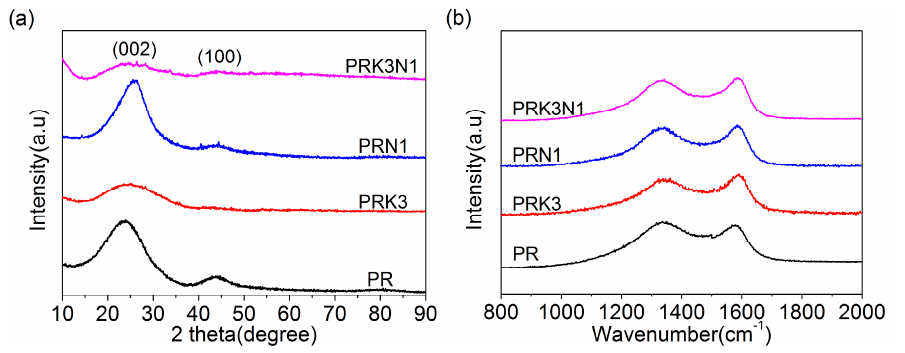
Figure 2. ( a ) XRD patterns, and ( b ) Raman spectrums of PR, PRK3, PRN1 and PRK3N1. The micro-structure and morphology of all the samples are displayed in Figure